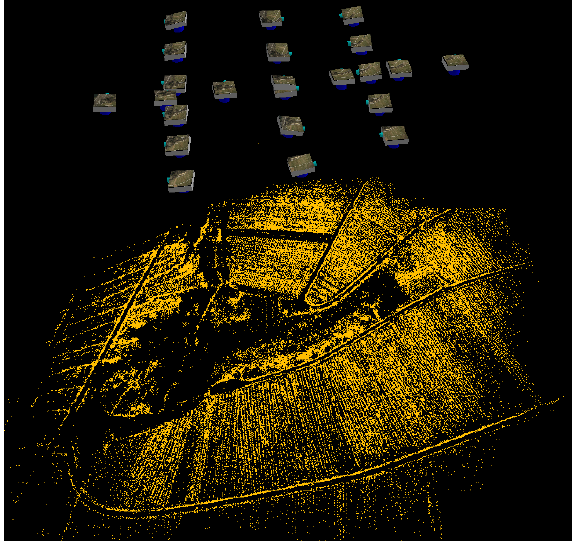
Figure 4. Configuration of the 23,000-point Hessigheim UAV